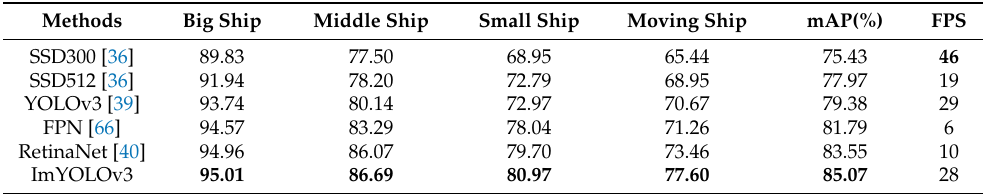
Table 4. Detection average precision (%) and speed of different methods on MSD. The entries with the best APs for each object category are